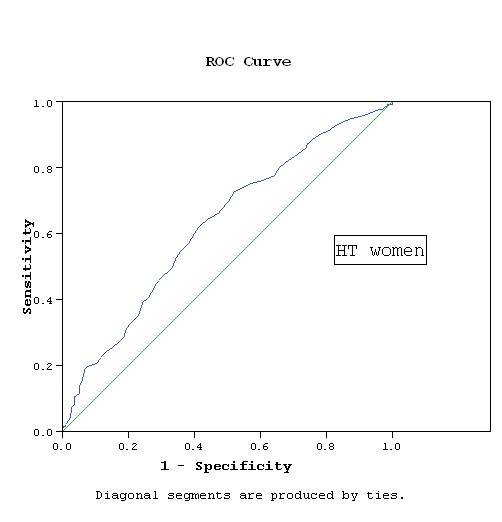
WC cutoff point by ROC curve in HT women. AUC = 0.63, p < 0.001 CI: 0.587- 0.673.